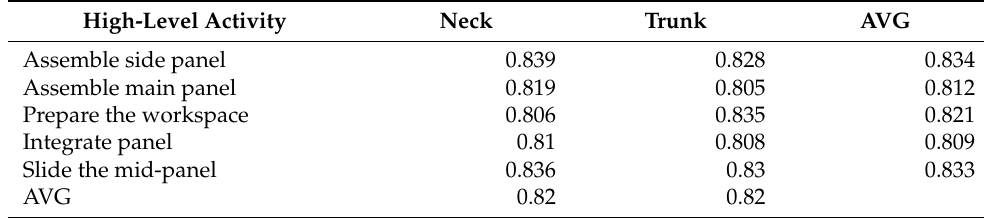
Table 8. Similarity measurement results for section B.